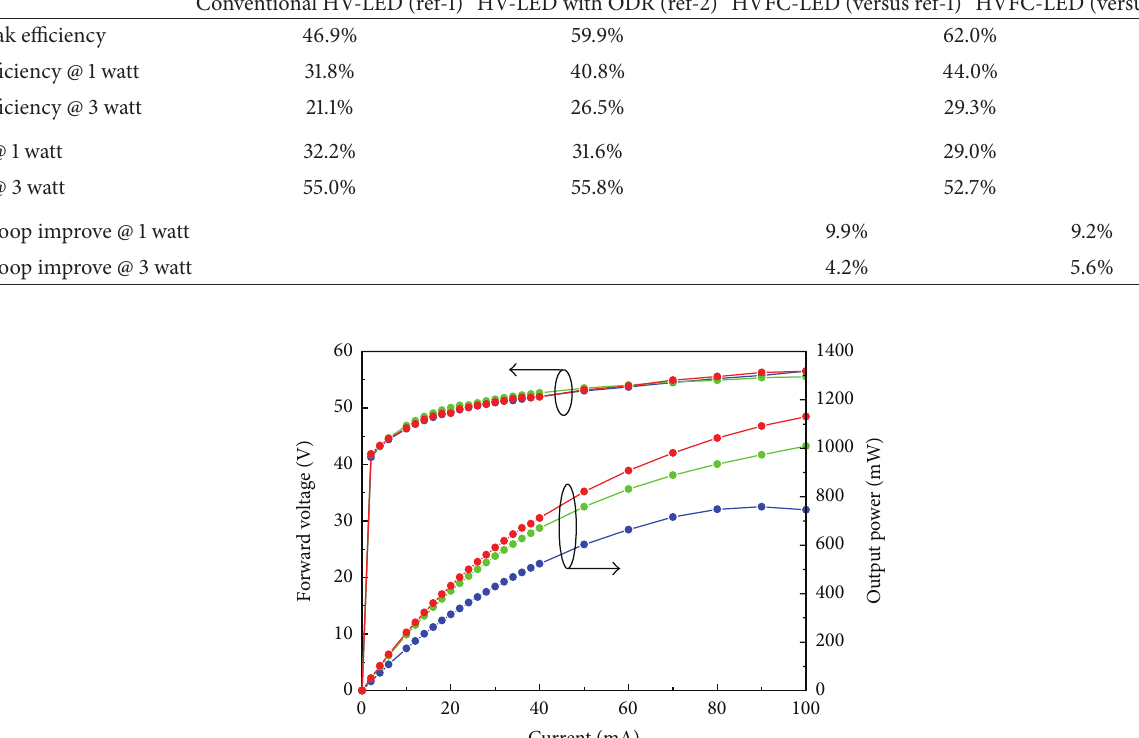
versus Al 2 O 3 ∼ 25 W/mK) and not any effect by electrode shadow, thus leading to higher light output power and better